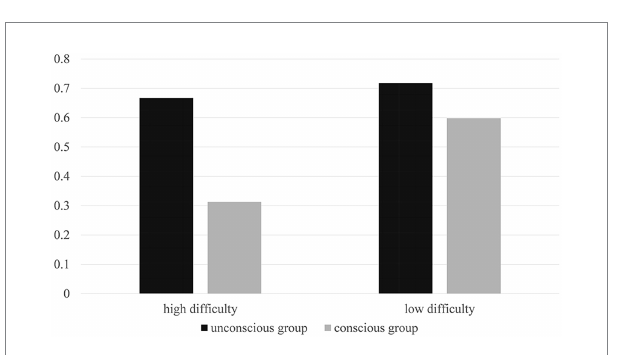
FIGURE 2 The accuracy rate of Experiment